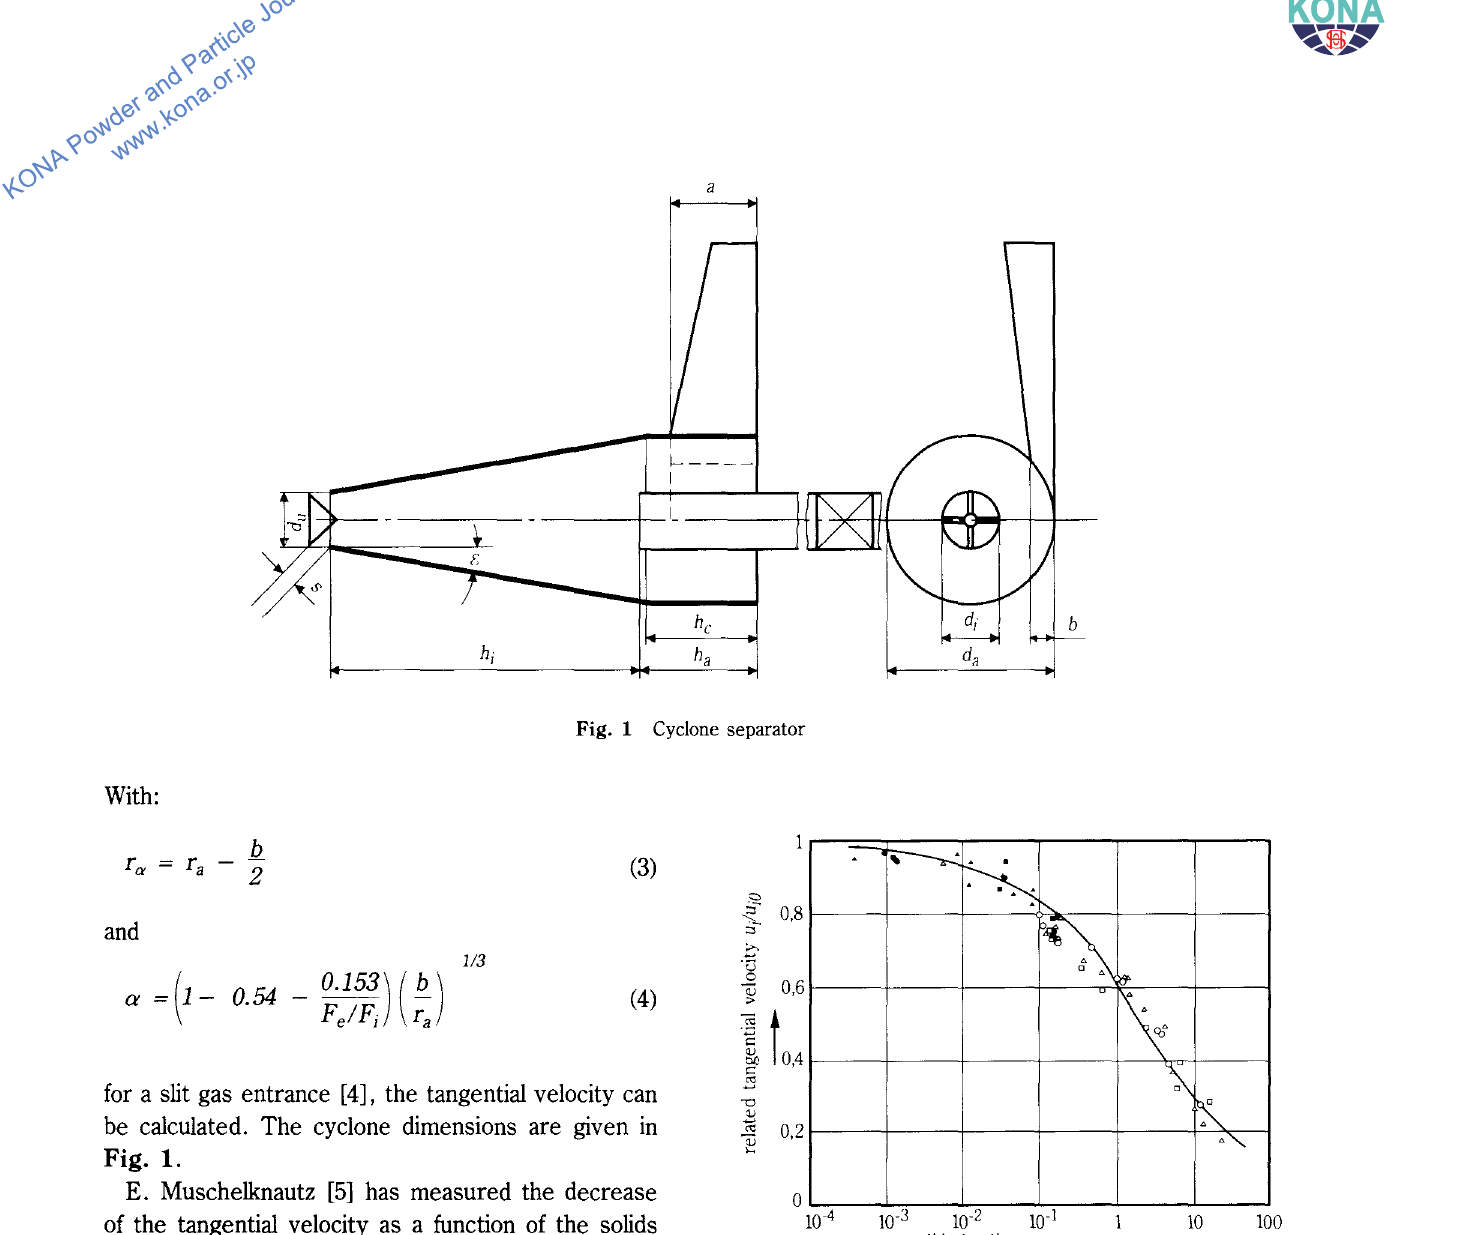
Fig. 1 Cyclone separator